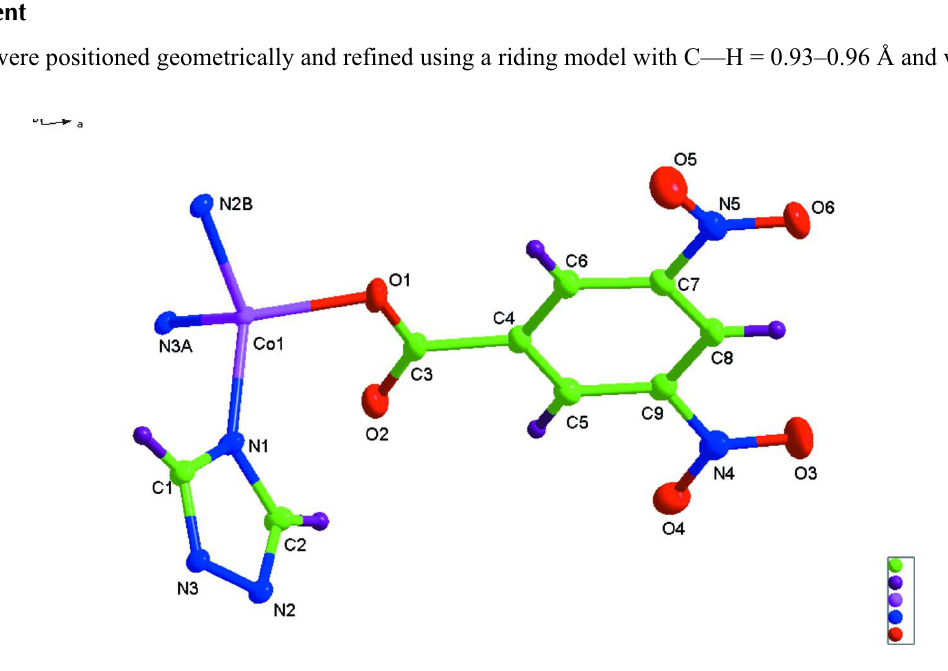
An ORTEP view of the asymmetric unit with 50% displacement ellipsoids for non-H atoms. Symmetry codes: (A) - x , y - 1/2,- z + 1/2; (B) x ,- y + 1/2, z +